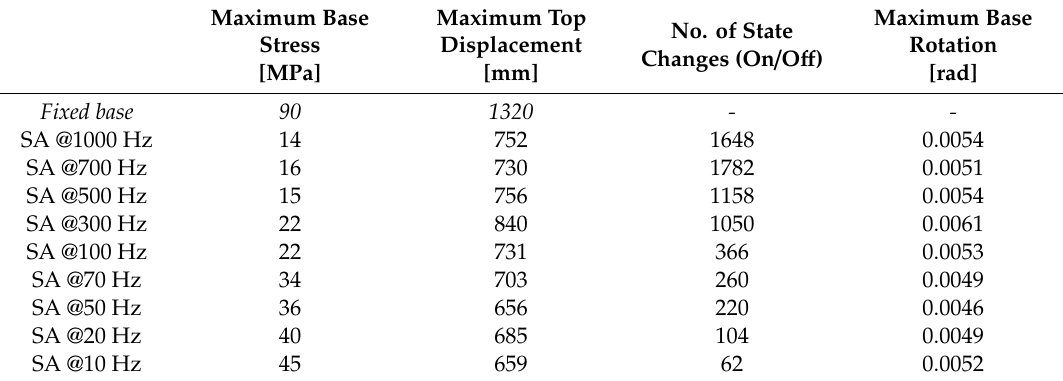
Table 3. Peak response of the wind turbine by varying the frequencies of